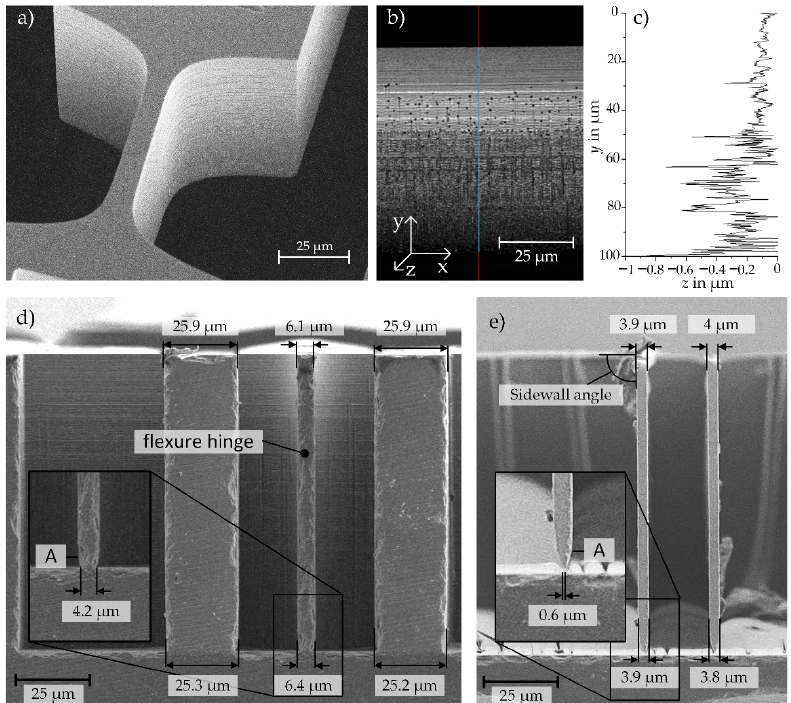
Figure 8. ( a ) scanning electron microscopy (SEM) images showing a flexure hinge, ( b ) exemplary device layer sidewall image as recorded by laser-scanning microcopy (LSM), and ( c ) an according topography profile, ( d ) SEM image of the cross section of a cutted flexure hinge with a designed height of h = 7 µm, ( e ) SEM image of the cross section with a designed height of h = 5 µm.